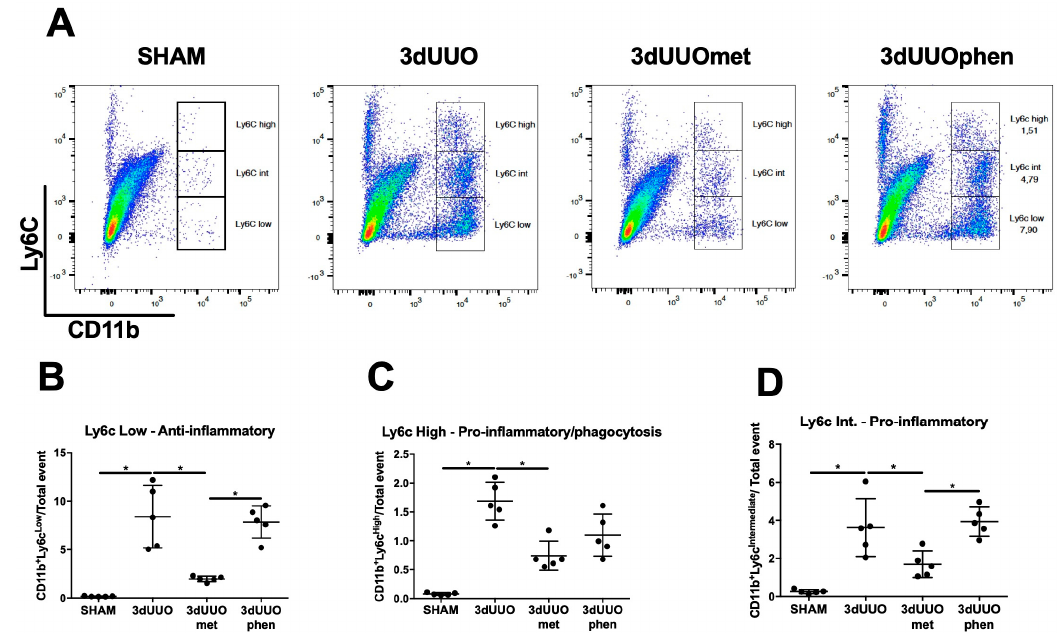
Figure 7. Ly6C monocyte cell infiltration into the UUO kidney is not affected by phenformin. ( A ) Dot-plot of kidney cells separated by cluster of differentiation 11b (CD11b) and Lymphocyte antigen 6 complex (Ly6C) expression. ( B – D ) Graphs showing the relative proportion of monocyte subpopulations in the kidney defined by Ly6C expression. n = 5 for each group. Each bar represents the mean ± SEM. * p < 0.05.